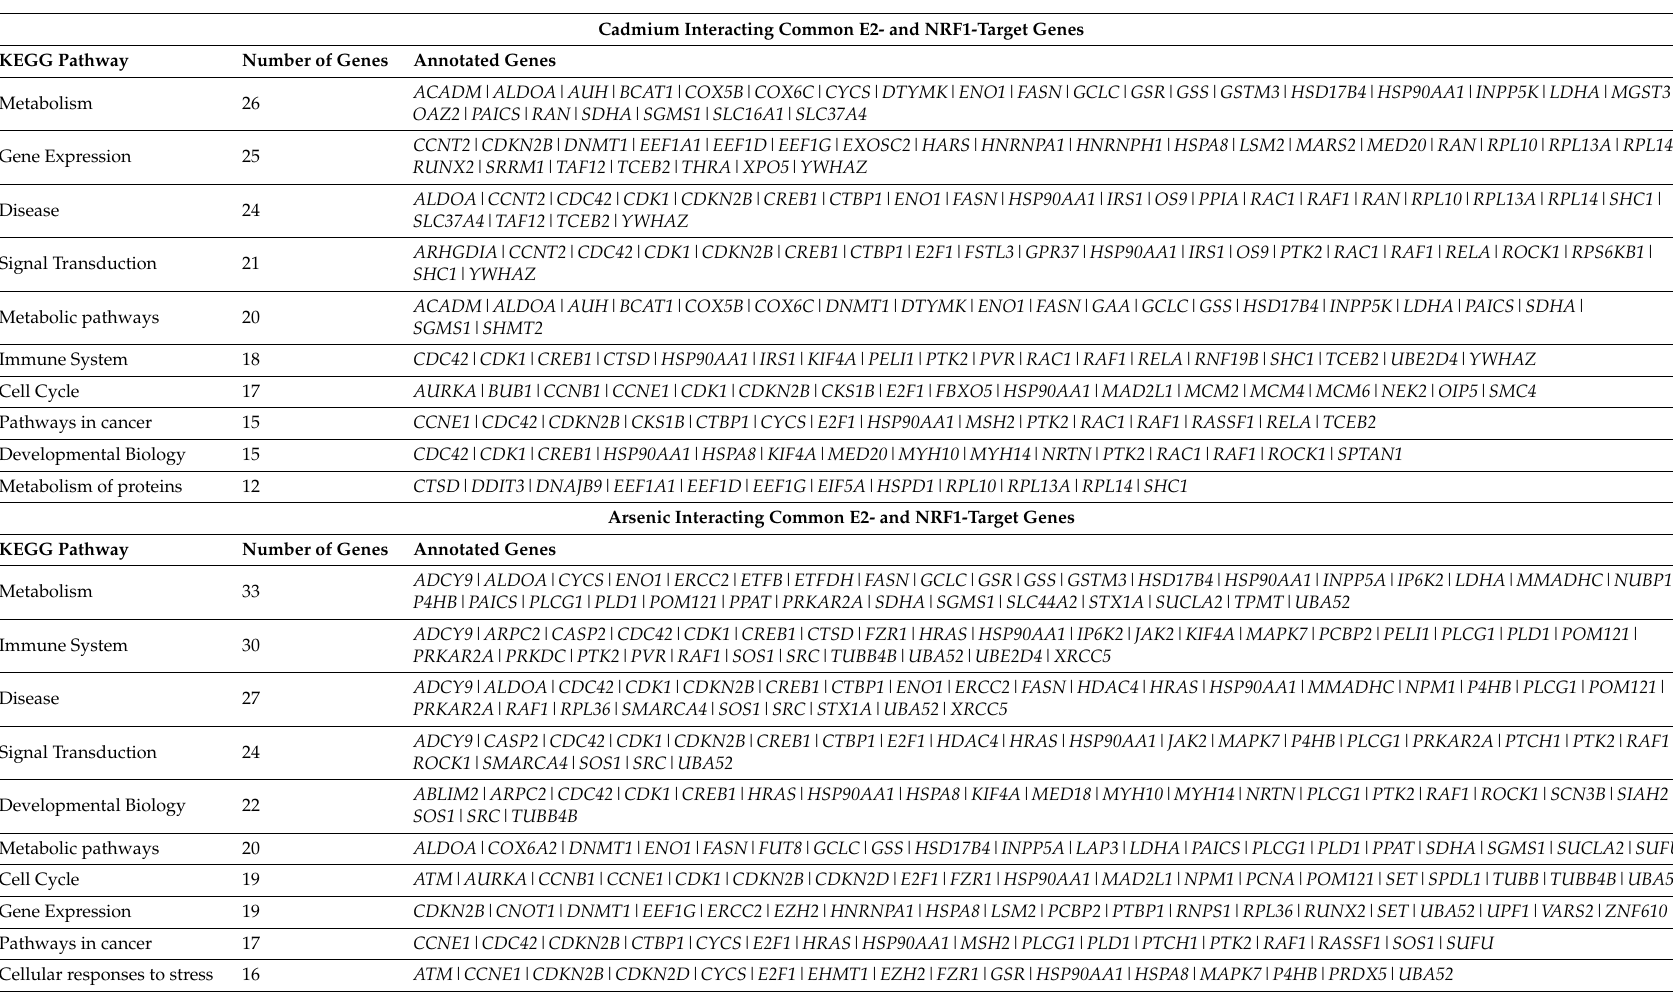
Cadmium Interacting Common E2- and NRF1-Target